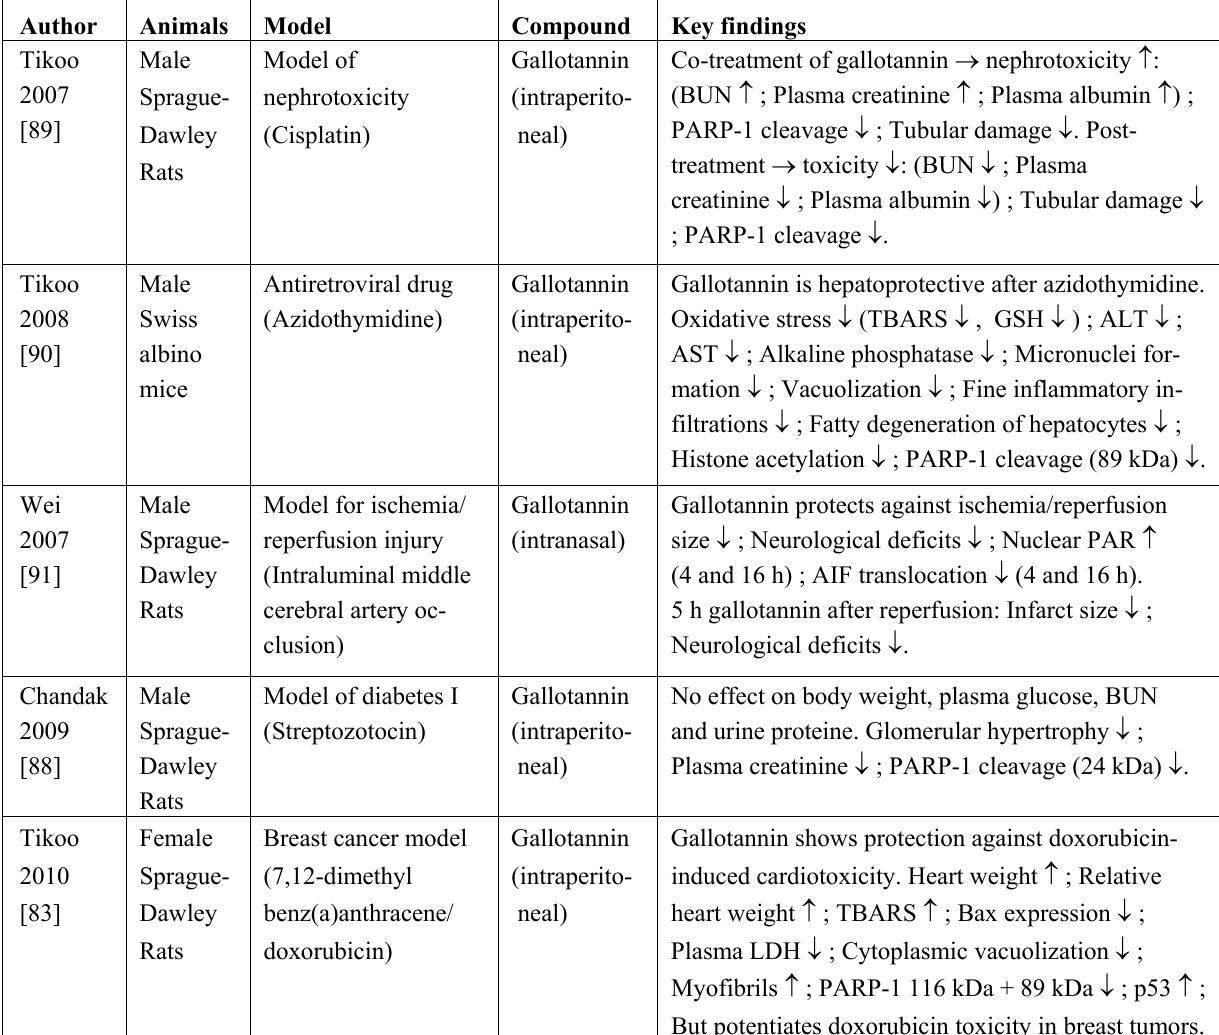
Table 3. Effects of the potential PARG inhibitor gallotannin in animals. Key